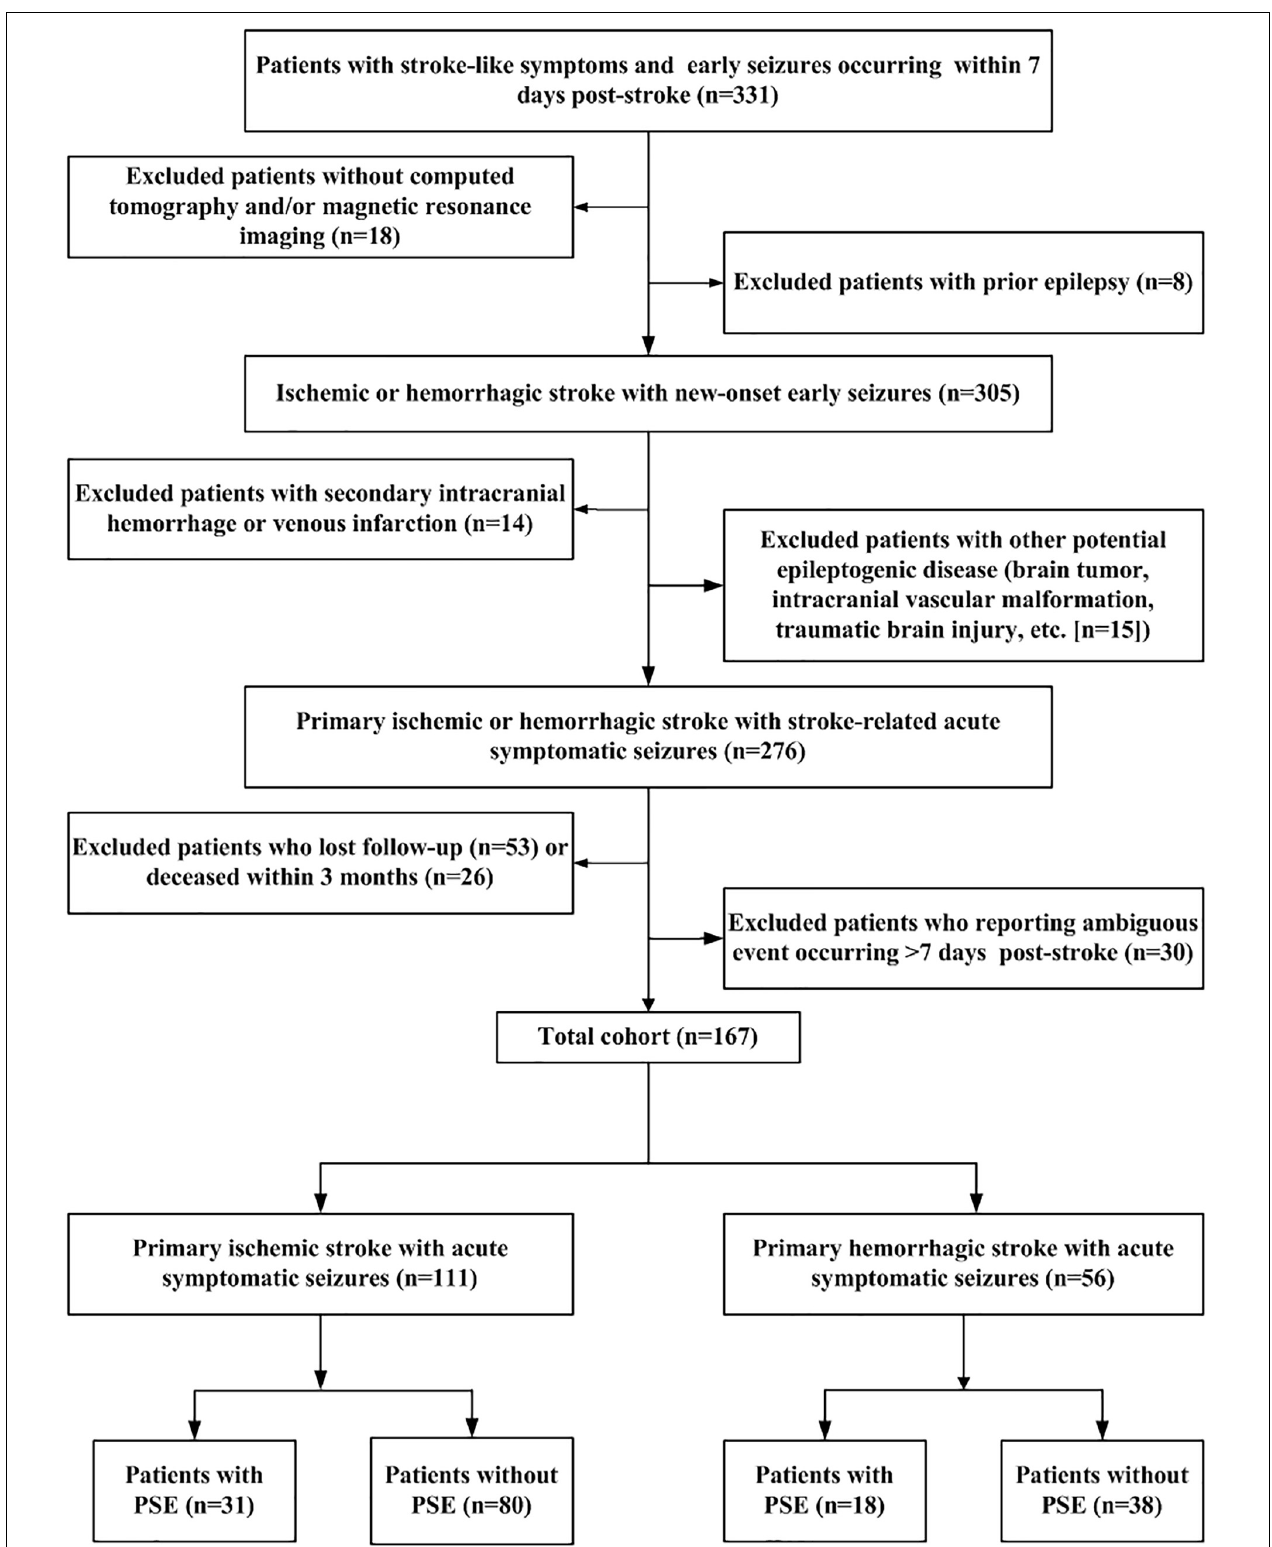
FIGURE 1 | Flow chart of patient recruitment. Flow-chart summarizing sequential application of inclusion/exclusion criteria leading to definition of final study cohort. PSE: post-stroke epilepsy.